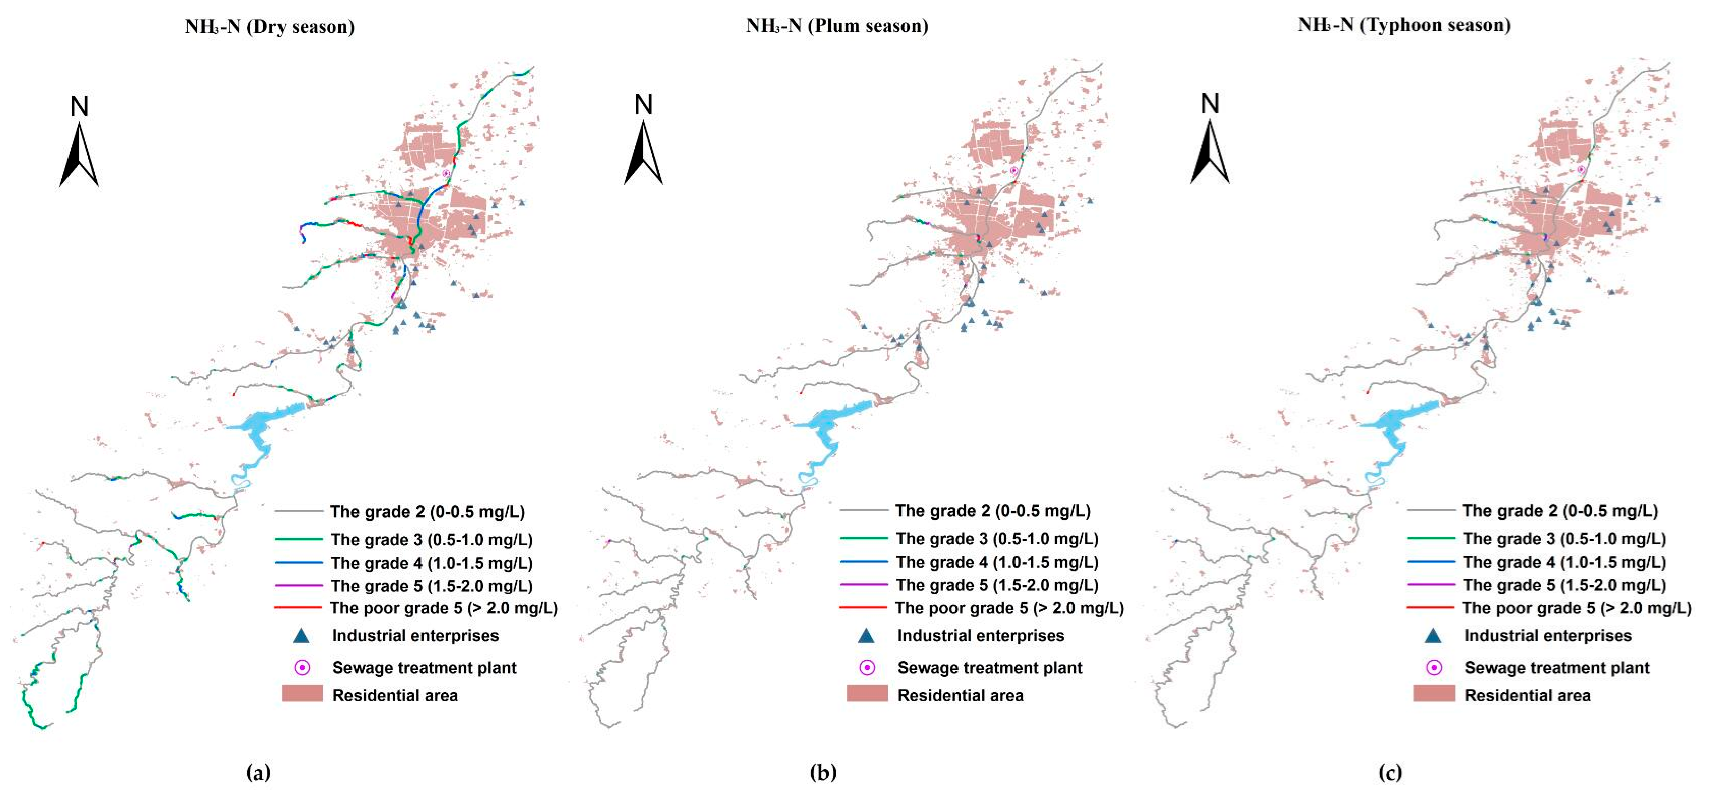
Figure 8. The space–time distribution of NH 3 -N water quality standard for the Xian-Jiang Basin: ( a ) concentrations in the dry season; ( b ) concentrations in the plum rain season; and ( c ) concentrations in the typhoon season.